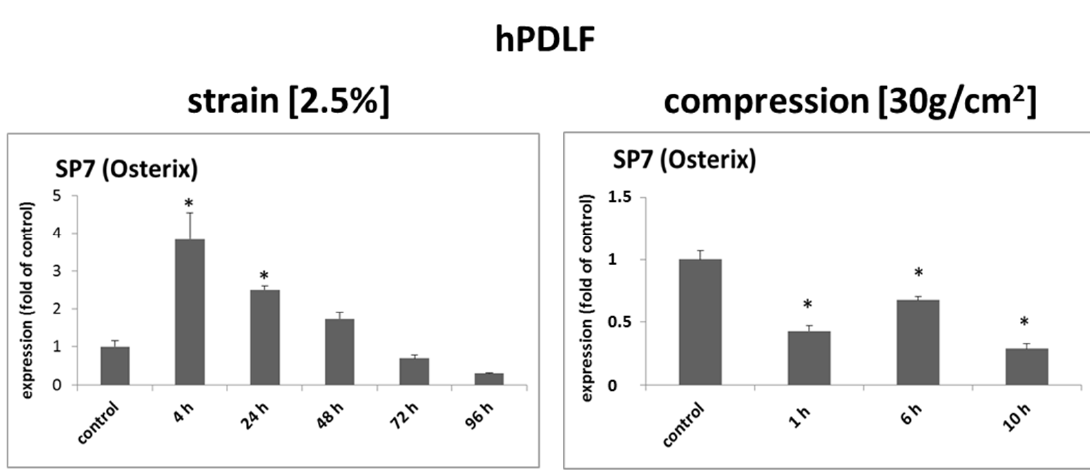
Figure 4. Osterix (SP7) is induced by mechanical strain in human primary periodontal fibroblasts. Three independent primary human PDLF (hPDLF) populations were either stretched (2.5%) or compressed (30 g/cm 2 ) for the indicated periods of time. Stretching and compression had opposite effects on the expressions of Osterix (SP7). Experiments were carried out in triplicate. Untreated cells served as controls. Quantitative RT-PCR experiments were carried out in triplicate. Cumulative data of the three cell populations data are given as mean ± SD. * = p < 0.05 vs. control (Kruskal–Wallis one-way analysis of variance on ranks (ANOVA), followed by Dunn’s post-hoc test).